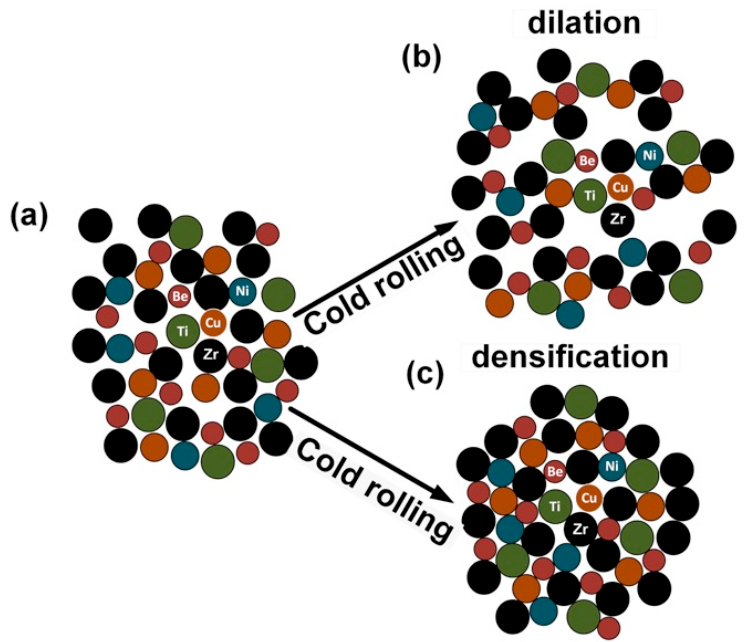
Figure 11. Schematic illustration of ( a ) the atomic arrangement in the glassy structure, ( b ) local di- lation causing enhanced free volume content, as well as ( c ) densification during cold rolling.